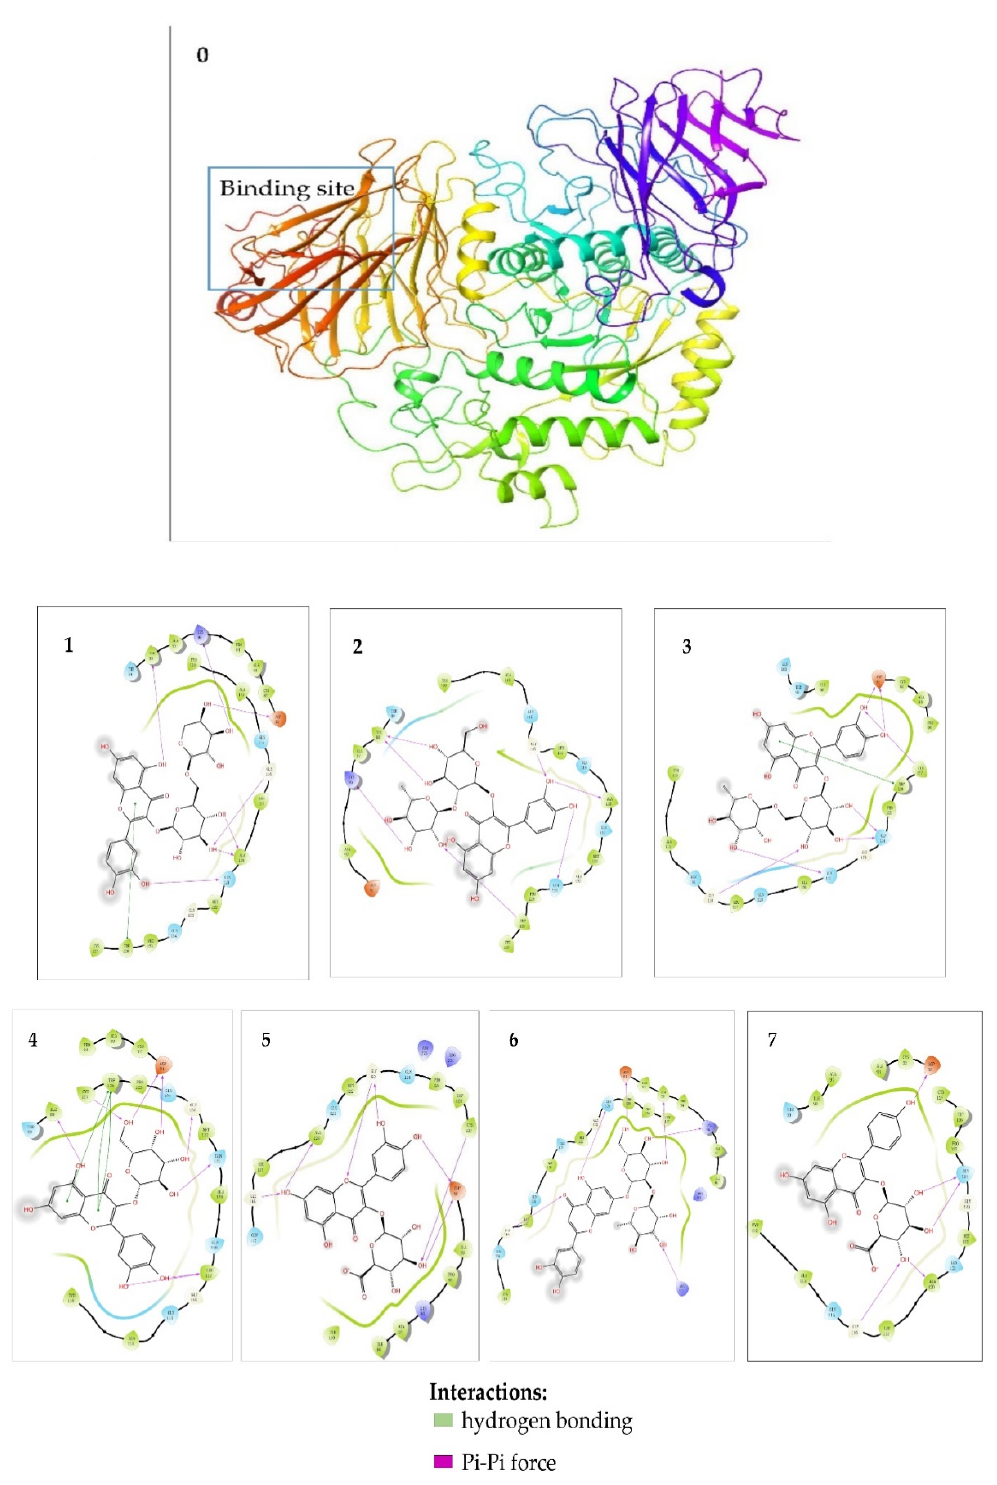
Figure 5. Molecular docking analysis of seven compounds with alpha-glucosidase. Alpha-glucosidase ( 0 ), quercetin − 3 − O − vicianoside ( 1 ), quercetin 3 − O − neohesperidoside ( 2 ), rutin ( 3 ), hyperoside ( 4 ), quercetin 3 − O − glucuronide ( 5 ), luteolin − 7 − O − neohesperidoside ( 6 ), kaempferol 3 − glucuronide ( 7 ).